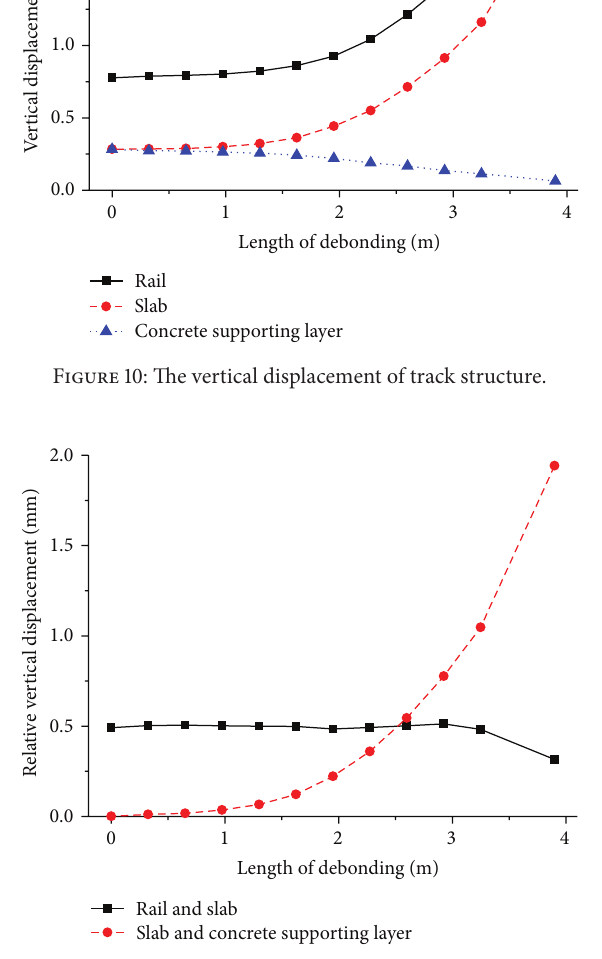
Figure 11: The vertical relative displacement of track